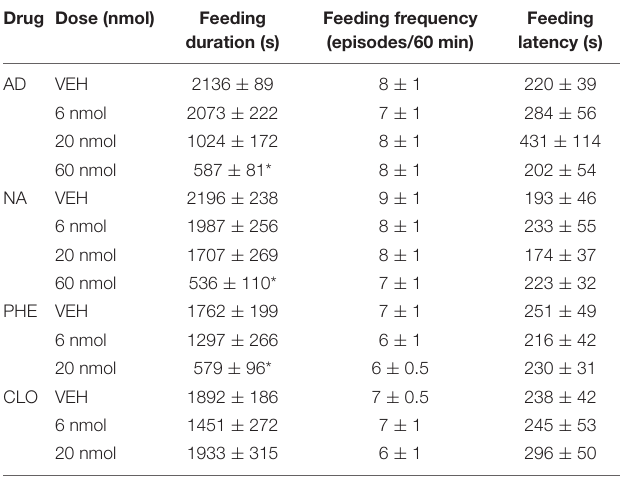
TABLE 2 | Feeding duration, feeding frequency and feeding latency during 60 min of recording after injection of adrenaline (AD), noradrenaline (NA), phenylephrine ( Table 2 ). Similar to the results found in the AD and NA (PHE), clonidine (CLO), or vehicle (VEH) into DR of fasted rats. experiments, feeding frequency and latency to start feeding were also not affected by PHE injection ( Table 2 ). Water intake Drug Dose (nmol) Feeding Feeding frequency Feeding ( Figure 3B ) decreased after PHE injection of 6 and 20 nmol duration (s) (episodes/60 min) latency (s)